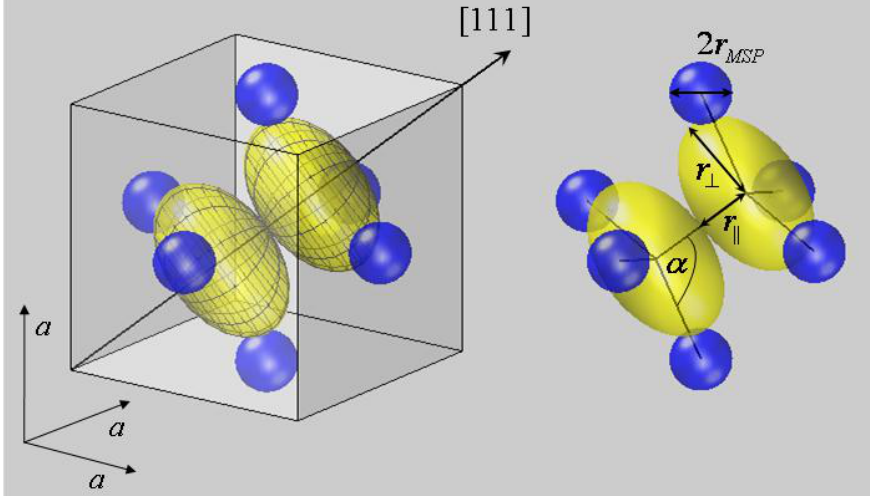
Figure 2. Bonding coordination of the sulfur dumbbell in FeS at ( uuu ) and ( uuu ). 2 ( a ) Within the crystallographic unit cell and ( b ) as S Fe cluster with internuclear axes. 2 6 According to the presented approach, ellipsoidal deformations are allowed to occur for S anions on three ( C ) symmetry sites, but might be neglected for Fe cations. The bond 3 partner of sulfur dimers S form two interpenetrating tetrahedrons with the neighbor S 2 residing on top and three Fe 2+ forming the basis. The tetrahedrons itself are compressed as are the sulfur ellipsoids. The latter exhibit a smaller radius parallel to the <111> axis r || compared to the perpendicular radius . Comparable geometries are found for the other pyrite-type compounds listed in Table